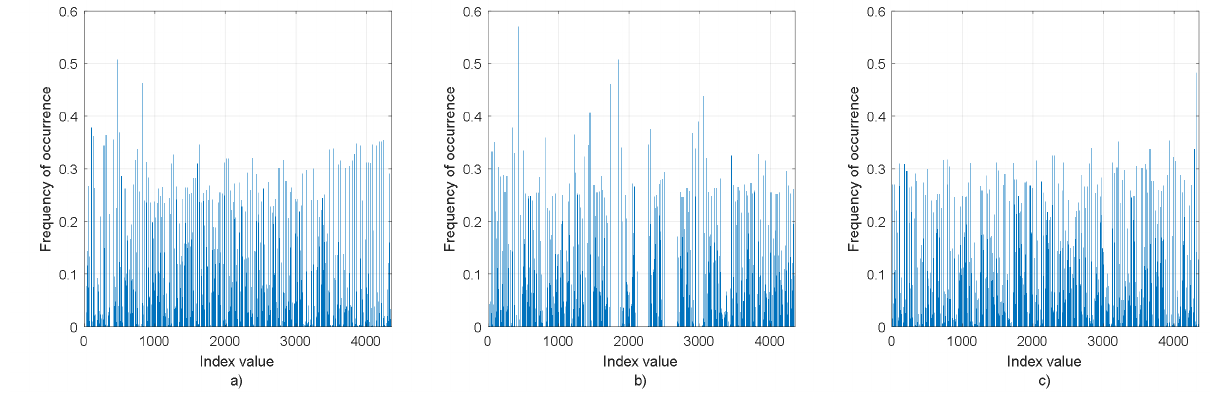
Figure 6. ( a ) HOG of an LG 08 mode, ( b ) HOG of an Mux-LG 0 ± 8 mode, ( c ) HOG of an HG 33